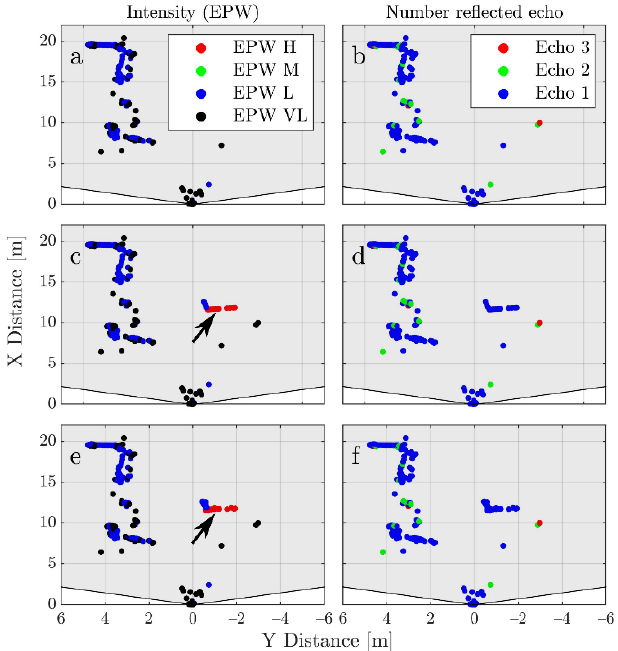
Figure 7. Examples of a real frame before ( a , b ), after augmentation ( c , d ) and after adding noise ( e , f ). On the left side the detections are colored based on the EPW value and on the right based on the echo number. The frame in ( a , b ) is the corresponding real frame to the synthetic one shown in Figure 6a,b. The arrows mark the position of the box after augmentation. Notice how the intensity distribution on the box makes physical sense due to the way in which the synthetic data was generated. The echo number is also plausible. The effect of adding noise extracted from real measurements ( e , f ) also increases the